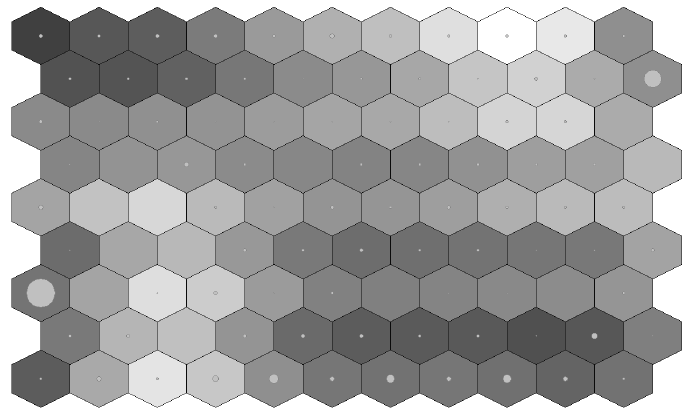
Figure 4. Unified distance matrix of input load